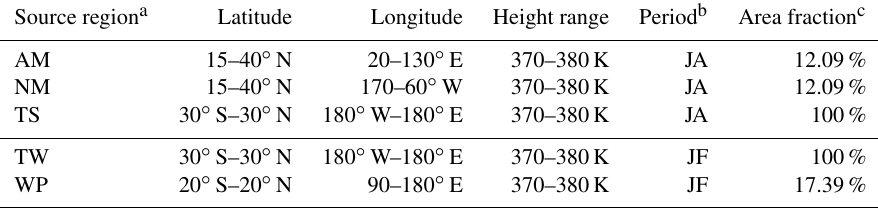
Table 1. Details regarding tagged regions, height range and time periods of tracer initialization for the different source regions.